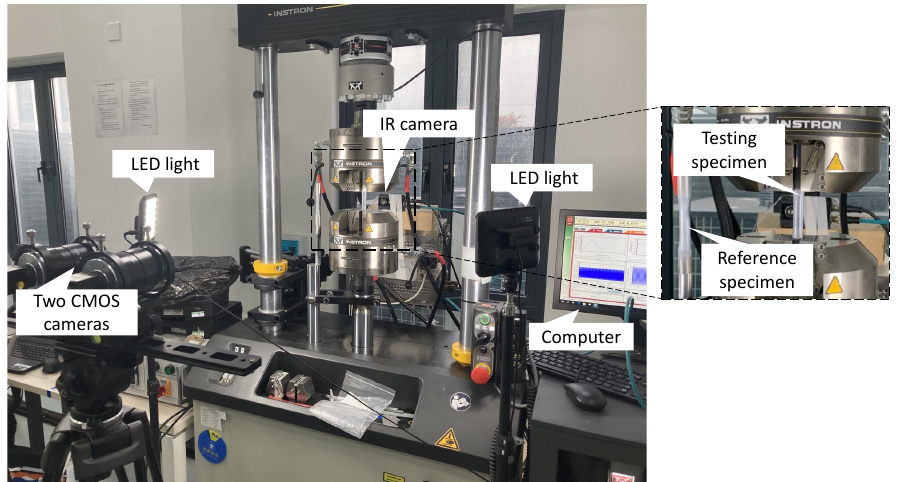
Figure 3. Experimental setup of the fatigue test with an infrared camera and a Digital Image Correlation (DIC) system of two Complementary Metal Oxide Semiconductor (CMOS) cameras.